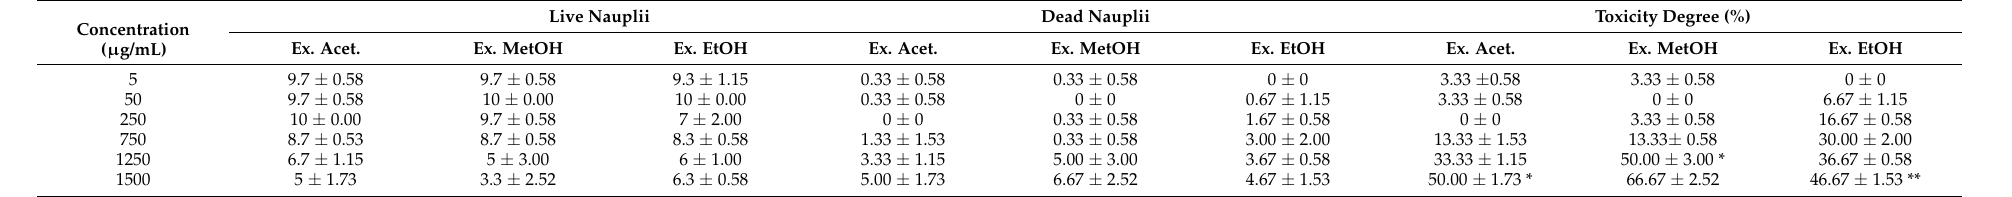
Table 2. Toxicity bioassay on Artemia salina nauplii of N. incerta extracts at different